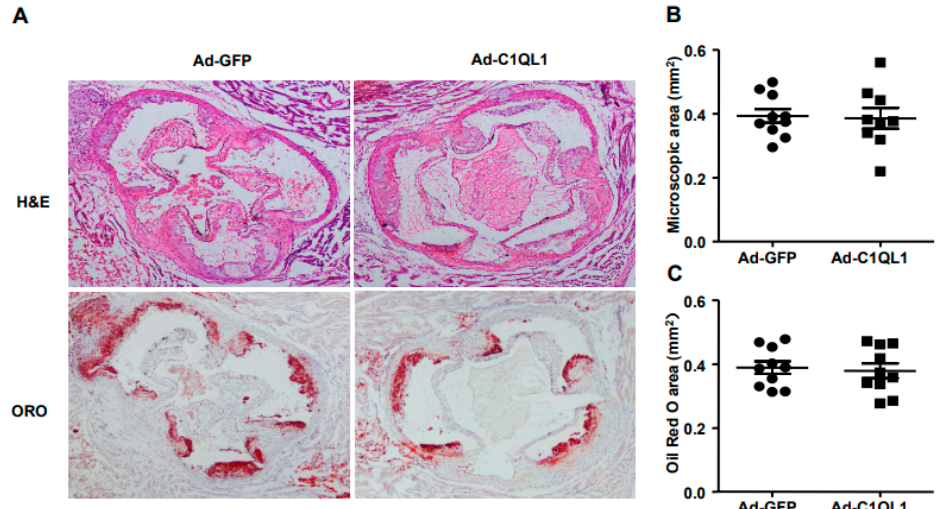
Figure 6. Illustrative micrographs of atherosclerotic lesions of the aortic root. ( A ) Aortic root sections were stained using ORO and hematoxylin–eosin (H&E). ( B , C ) Quantitative analysis of aortic root lesion areas is illustrated on the right. n = 10 or 15 for each cohort. Data are presented as the mean ± SEM.